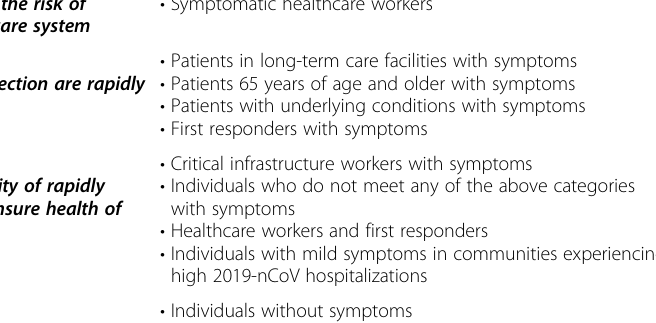
Table 2 Priorities for PCR testing of suspected COVID-19 patients according to CDC guidelines [18] Priority 1 Ensure optimal care options for all hospitalized patients, lessen the risk of nosocomial infections, and maintain the integrity of the healthcare system Priority 2 Ensure that those who are at highest risk of complication of infection are rapidly identified and appropriately